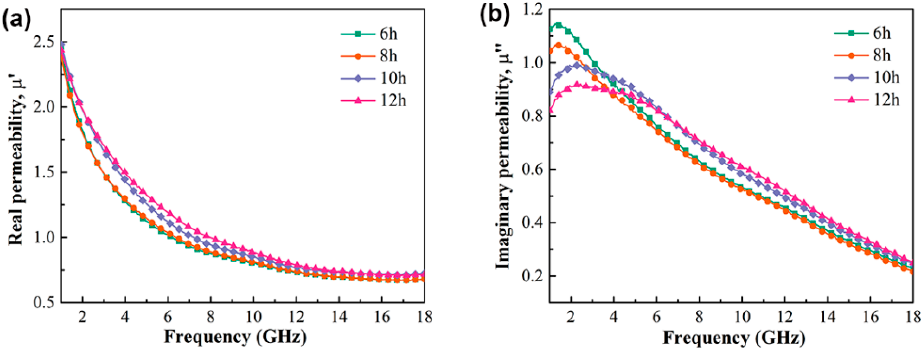
Figure 6. Frequency dependences of μ ′ ( a ) and μ ″ ( b ) of Fe 73.2 Si 16.2 B 6.6 Nb 3 Cu 1 nanocrystalline alloy powder.